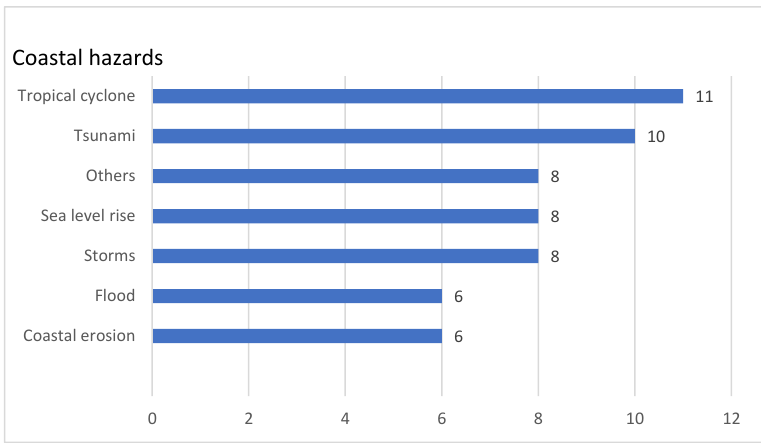
Figure 6. Distribution of studies according to coastal hazard type.